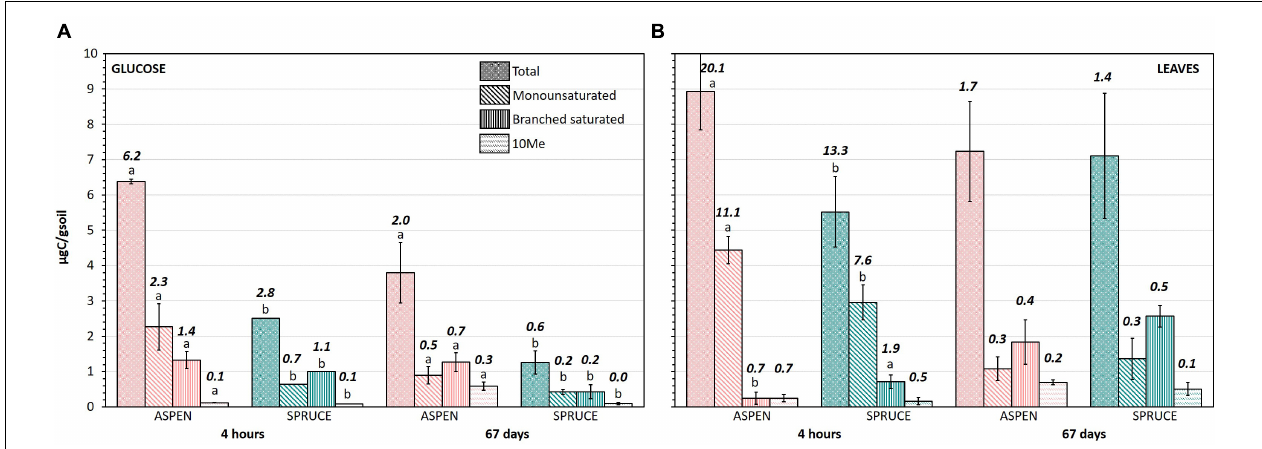
FIGURE 5 | Incorporation of (A) glucose and (B) aspen leaves into 10Me, branched saturated, monounsaturated, and total PLFAs for both aspen and spruce soil incubation units. Error bars show standard deviations over five replicates and different letters indicate significant differences between the aspen and spruce soil incubation units for each date (4 h and 67 days) and each PLFA grouping ( p < 0.05). The value indicated on top of each bar corresponds to the PLFA based-SUE value